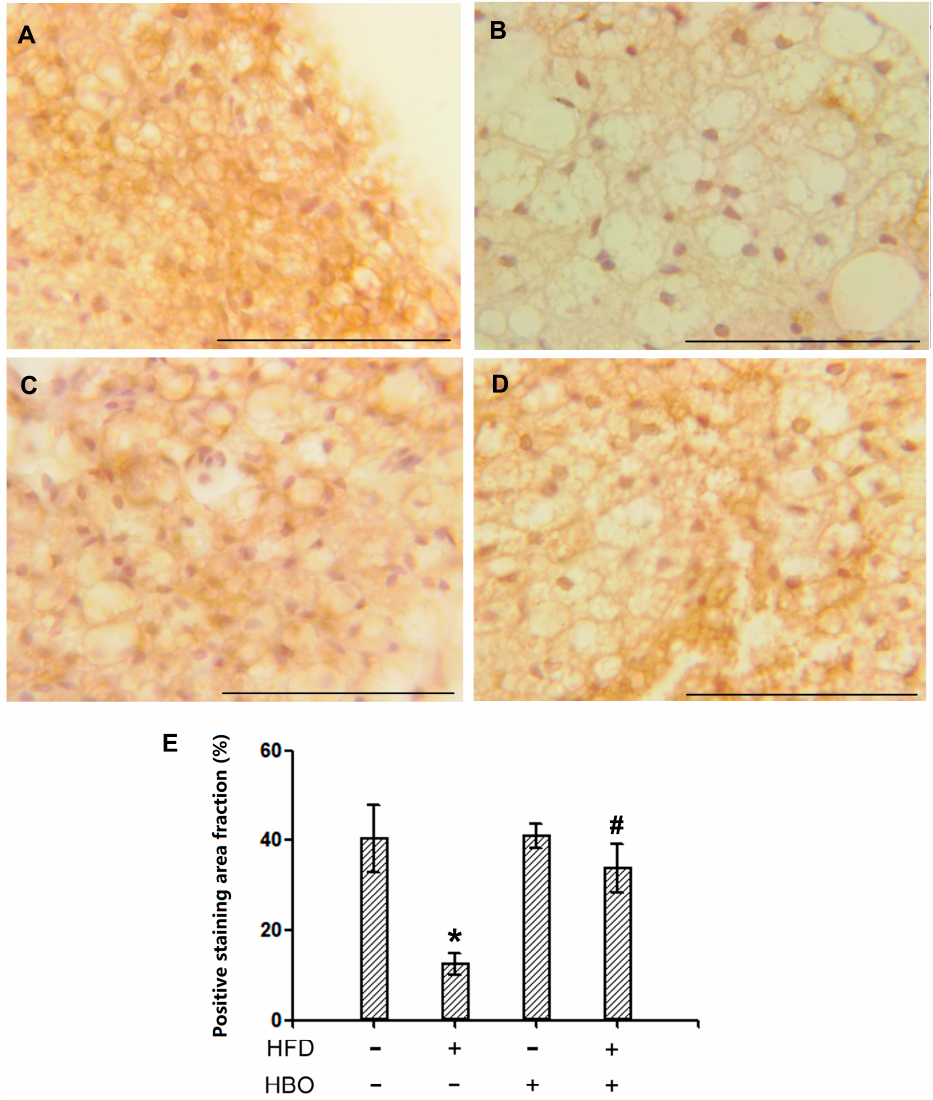
Figure 5. Immunohistochemistry for HSL on BAT. BAT tissues were fixed in 4% paraformaldehyde 24 h, and then histologically processed and sectioned at thickness of 6 um. Immunohistochemistry for HSL was performed following manufacturer’s instructions. Quantification was performed with ImageJ. Three samples from three independent animals were assessed per group. Error bars represent standard derivation. Scale bars represent 70 um. ( A ): Representative immunohistochemistry picture of BAT from control animals. ( B ): Representative immunohistochemistry picture of BAT from HFD-treated animals. ( C ): Representative immunohistochemistry picture of BAT from HBO-treated animals. ( D ): Representative immunohistochemistry picture of BAT from HFD + HBO-treated